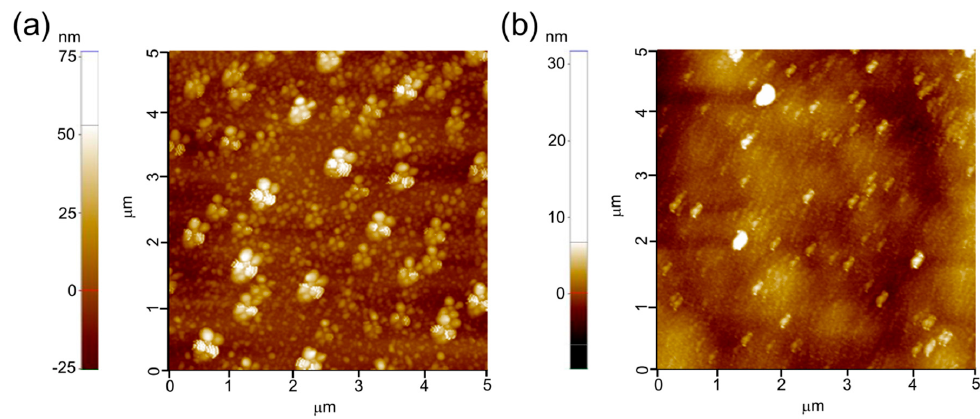
Figure 5. Surface morphologies of the PdAl/Au metal stack on p-type AlGaN: ( a ) as-deposited, and ( b ) annealed at 600 ° C.